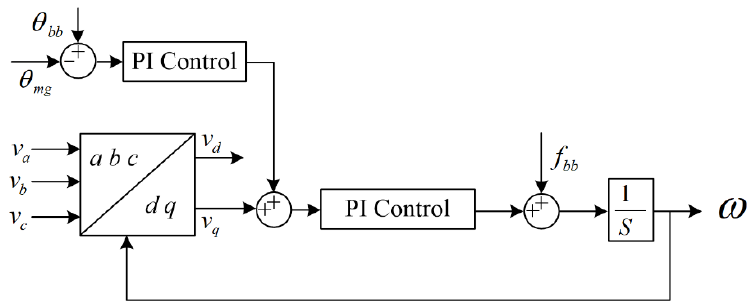
Figure 13. Control structure for the frequency and phase synchronization loop.